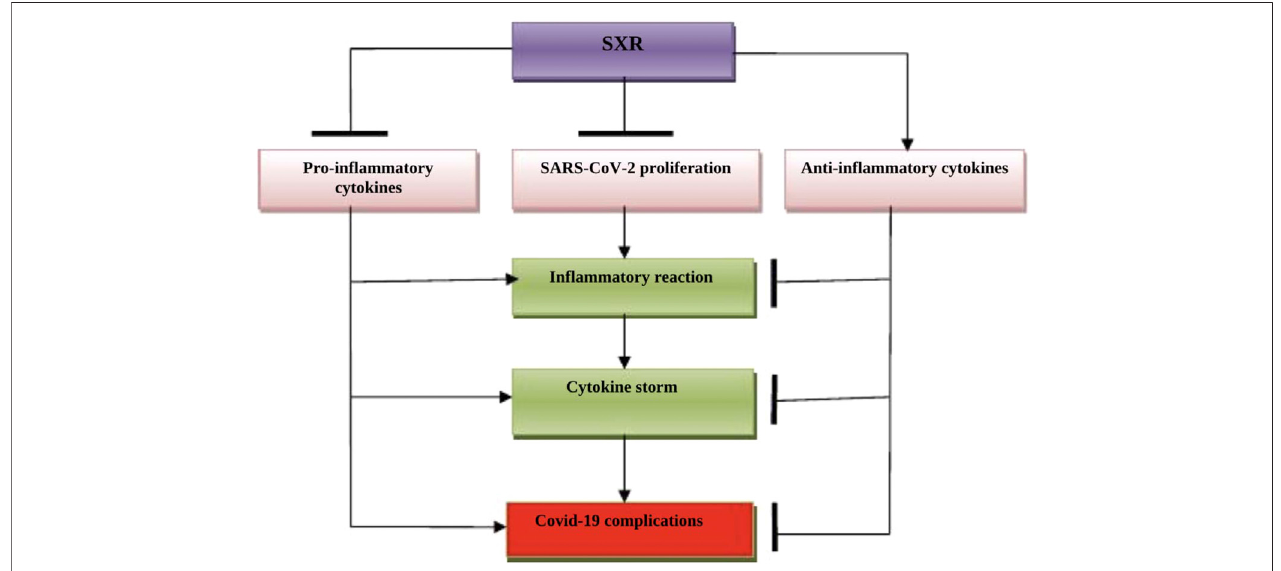
FIGURE 4 | The possible role of Selinexor (SXR) in COVID-19: SXR inhibits the proliferation of SARS-CoV-2 and the release of pro-in fl ammatory cytokines. SXR activates the release of anti-in fl ammatory cytokines, thereby preventing the development of a cytokine storm and COVID-19